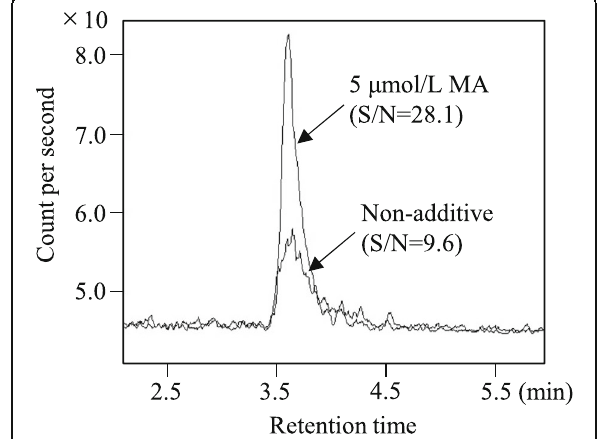
Fig. 2 Chromatograms peaks of 1 μ g/L glyphosate standard solution resulting from mobile phase with or without 5 μ mol/L of